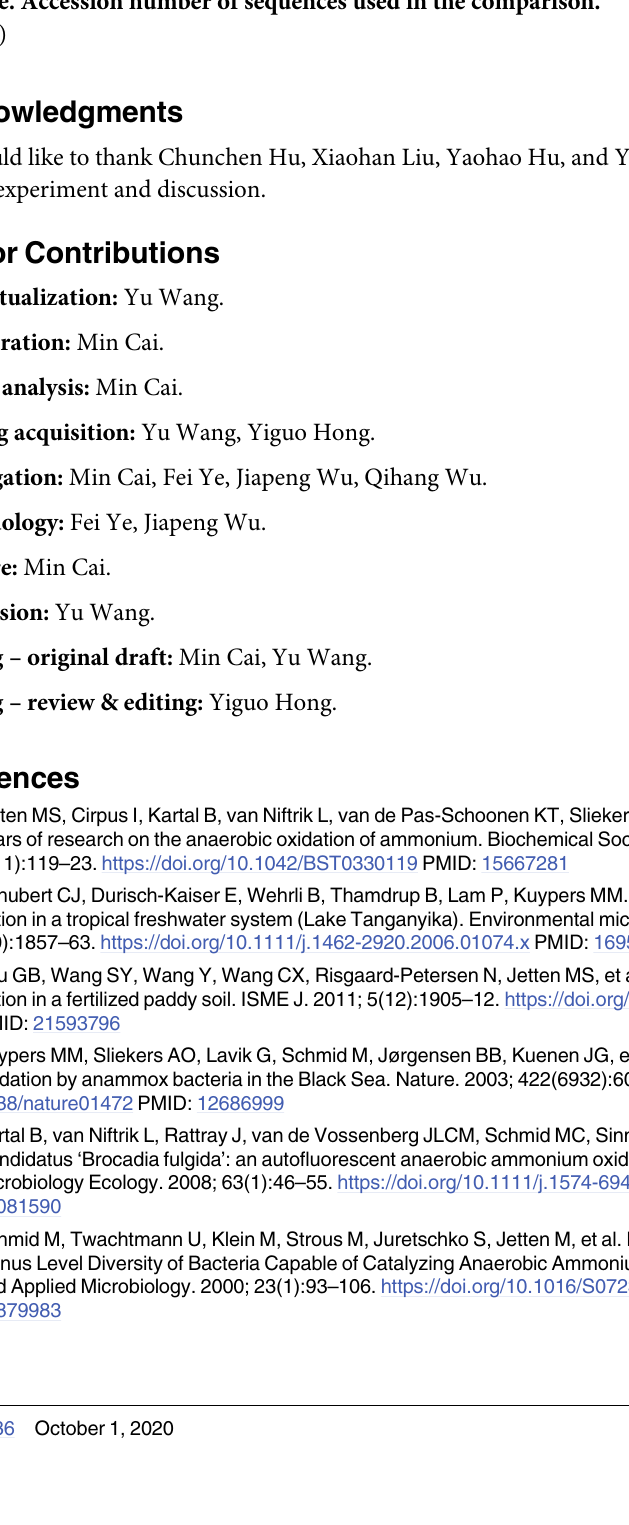
S1 Table. Accession number of sequences used in the